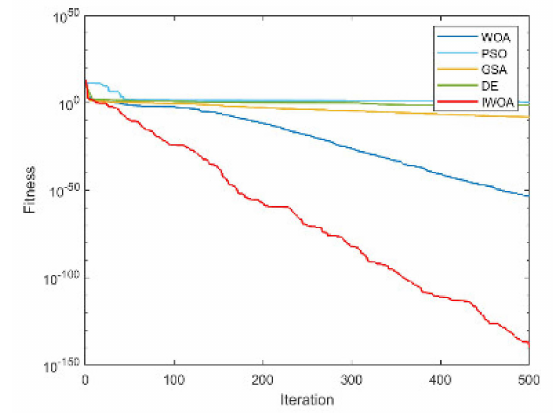
Figure A1. The convergence curve for solving F1.